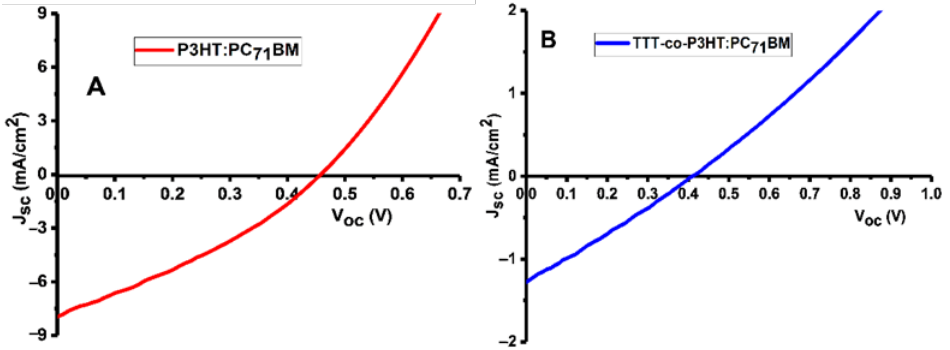
Figure 5. J–V plots of ( A ) P3HT:PC 71 BM and ( B ) TTT-co-P3HT:PC 71 BM devices. Table 3. Response of the TTT-co-P3HT:PC 71 BM and P3HT:PC 71 BM devices. Active Layer